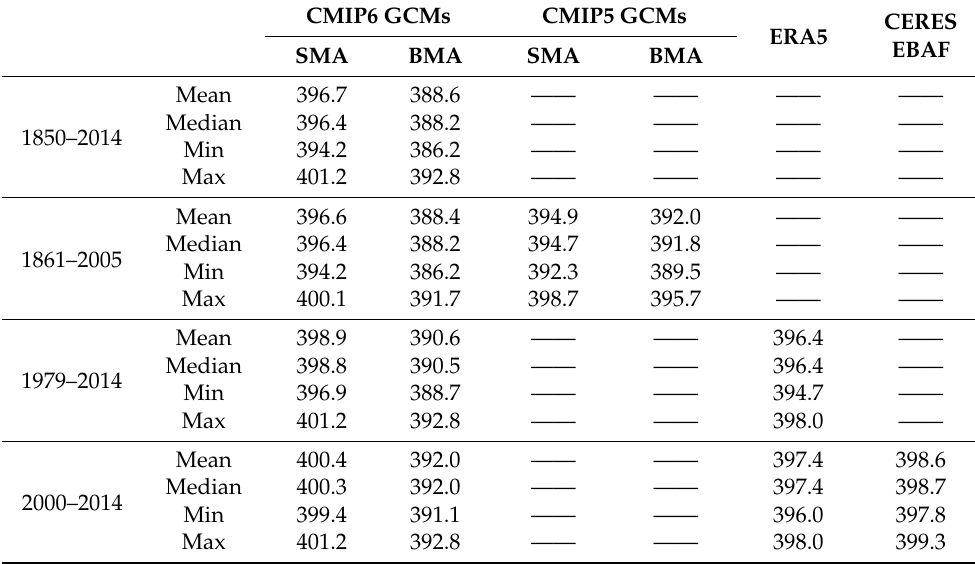
Table 4. Comparison of the global annual mean SULR of the CMIP6 GCMs, CMIP5 GCMs, ERA5, and CERES EBAF over different periods (in units of W m − 2